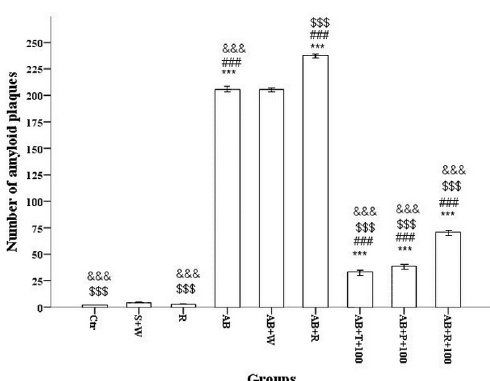
FIGURE 5 - Amyloid plaque numbers in different groups. Comparison of control group (Ctr) with other groups (*** p<0.001); comparison of restraint (R) group with other groups (### p<0.001); comparison of AD group (AB) with others ($$$ p<0.001); comparison of AD and restraint stress group (AB +R) with other groups ( &&& p<0.001). Please refer to the Methods and Materials section for the groups’ definitions. F-value: 3181.4.